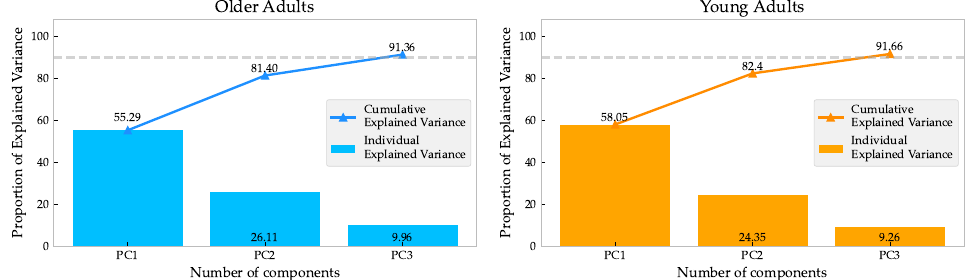
Figure 2. Percentage variance explained for each PC plotted individually in bars, and the cumulative variance explained with dots and lines for the older group ( left ) and the younger group ( right ). Only 3 PCs were necessary to describe the joint torques in